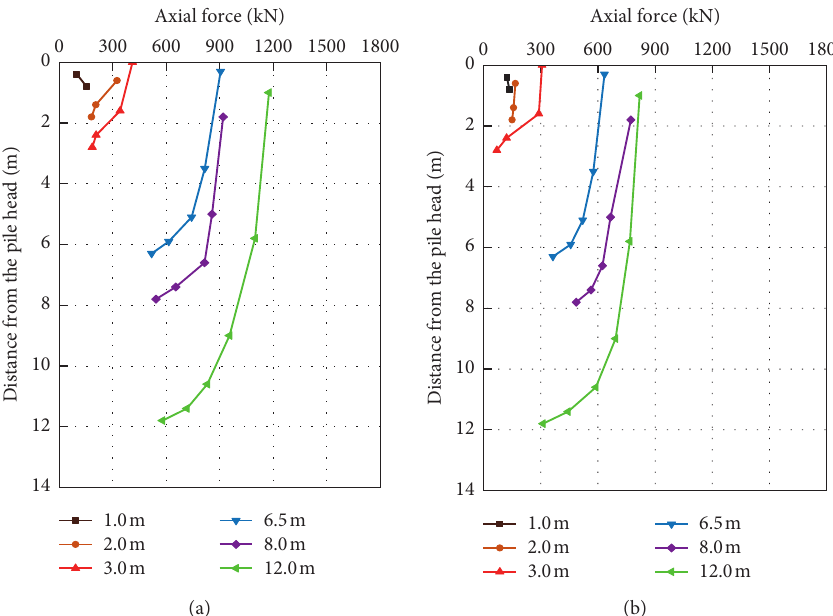
Figure 4: Axial force profiles along the piles at different penetration depths: axial forces of (a) P1 and (b) P2.